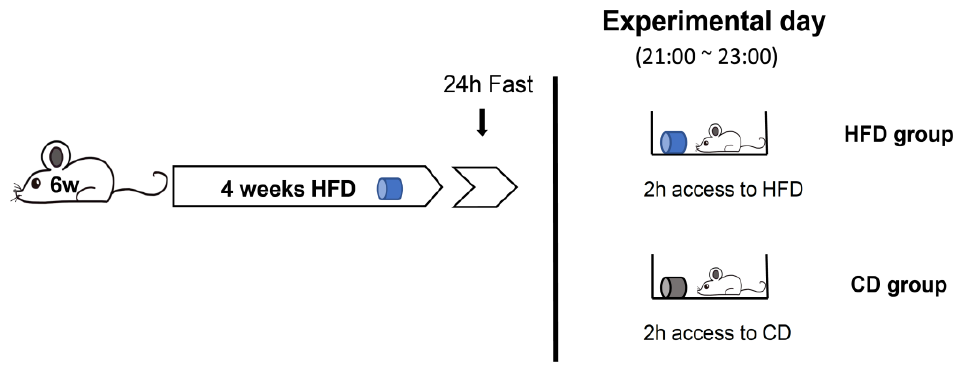
Figure 3. Refeeding of HFD after 24 h fasting gives rise to binge-like eating. The protocol for the experiment. WT and KO mice were exposed to a HFD for 4 weeks, and then were fasted for 24 h. On the day of the experiment, the mice were divided into two groups, ‘‘ HFD group ’’ and ‘‘ CD group ’’ . The HFD and CD groups were given HFD and CD, respectively, for 2 h.